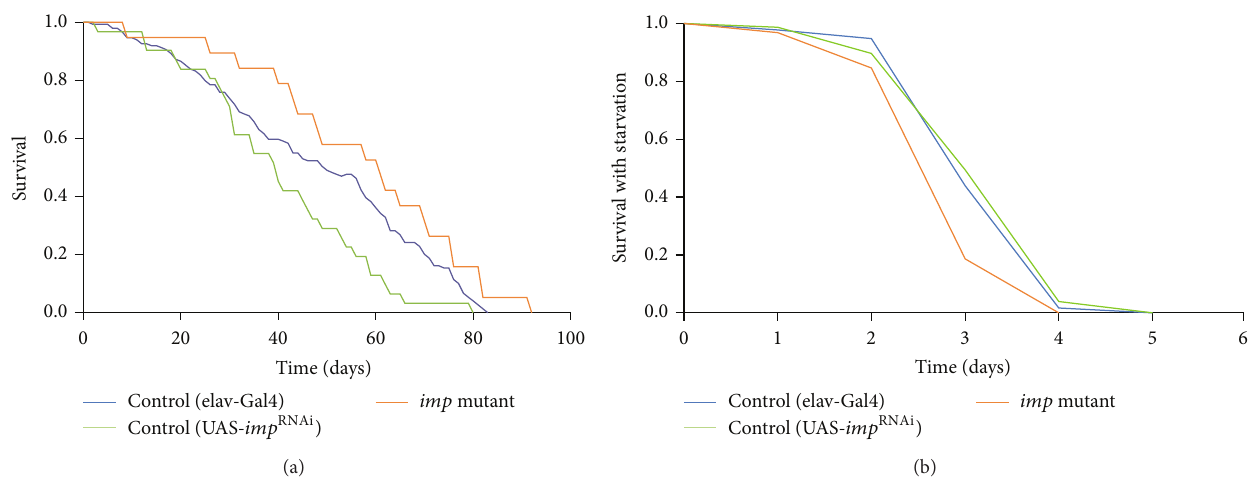
Figure 4: imp knockdown mutant exhibited longer lifespan and reduced starvation resistance. (a) Survival of elav-Gal4 virgin flies (blue, 𝑛 = 149 ), UAS- imp RNAi (green, 𝑛 = 31 ), and imp mutant [elav-Gal4; UAS- imp RNAi ] (orange, 𝑛 = 19 ). Median lifespans are as follows: elav-Gal4, 51 days; UAS- imp RNAi ; UAS-Dicer2, 40 days; elav-Gal4; UAS- imp RNAi 62 days, 𝑃 < 0.038 versus elav-Gal4, 𝑃 < 0.0004 versus UAS- imp RNAi (log-rank test). (b) Survival of virgin flies during starvation: elav-Gal4 virgin flies (blue, 𝑛 = 303 ), UAS- imp RNAi (green, 𝑛 = 77 ), and imp mutant [elav-Gal4; UAS- imp RNAi ] (orange, 𝑛 = 188 ). Average lifespans are as follows: elav-Gal4, 3.38±0.04 days; UAS- imp RNAi 3.42±0.05 days; imp mutant [elav-Gal4; UAS- imp RNAi ] 3.00 ± 0.09 days, 𝑃 < 0.0001 versus elav-Gal4, 𝑃 < 0.0001 versus UAS- imp RNAi (log-rank